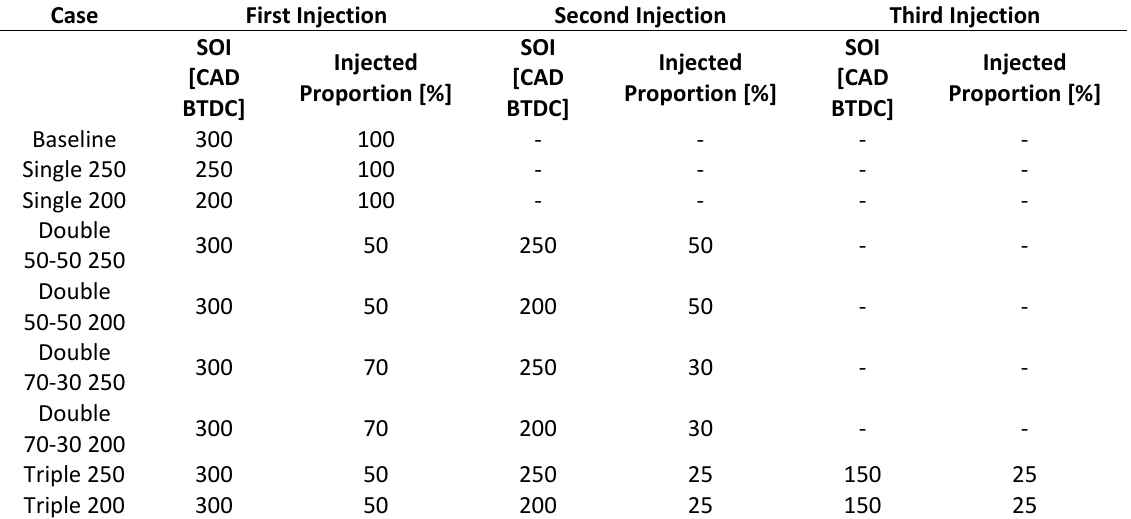
Table 2 . Operating points for studying split injection strategies at RPM = 2000, λ = 1.0, Load = WOT (wide open throttle) and SA (spark advance) = 15 CAD